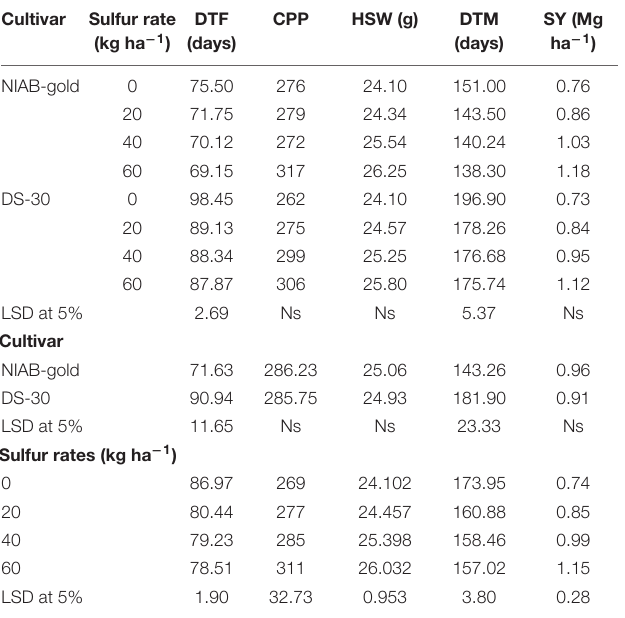
TABLE 5 | Effect of different cultivars and sulfur rates on days taken to 50% flowering, capsule plant − 1 , hundred seed weight, days taken to maturity, and seed yield of castor bean.